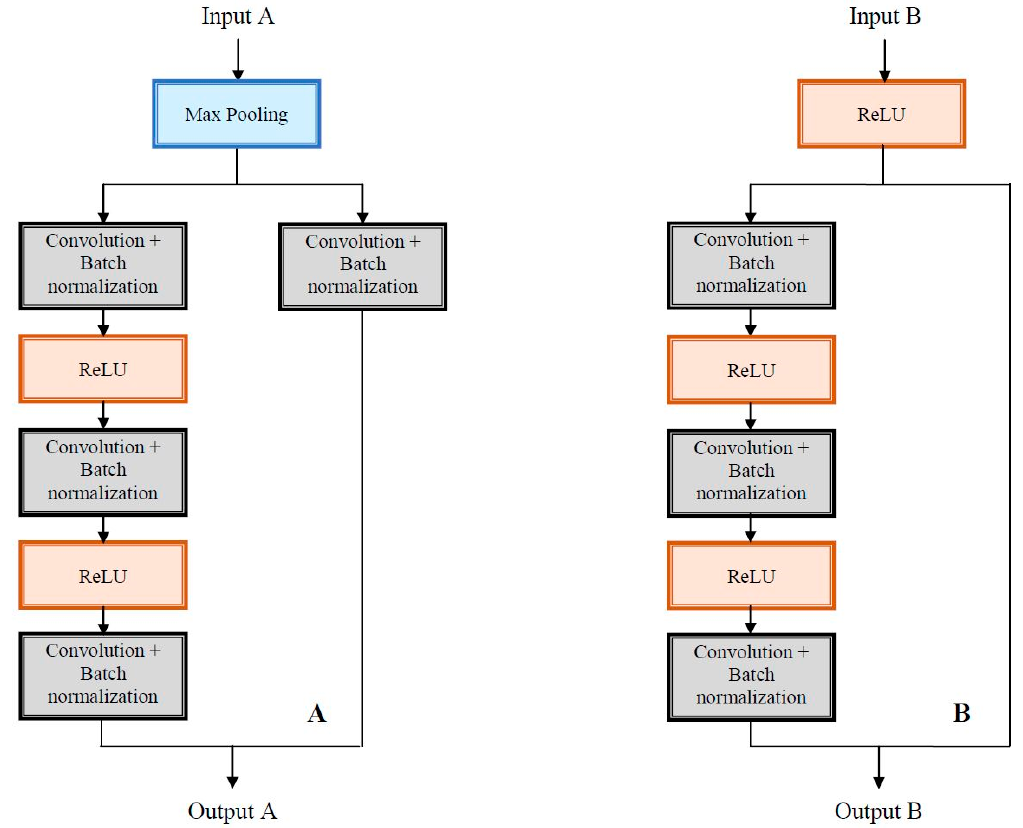
Figure 10. Repetitive modules in ResNet configuration.